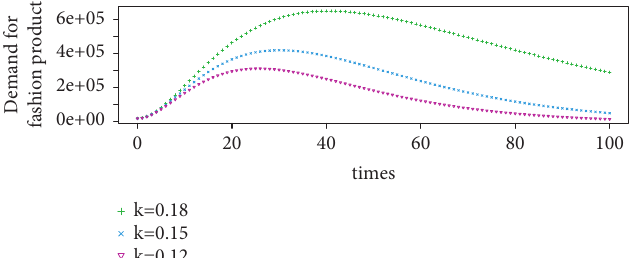
Figure 13: Simulation of the demand for fashion products at different effective rates of FPPEs application due to strict adherence to safety and precautionary measures. The effective rate of application ( k ) increases from 0.12 to 0.18, and the demand for fashion products shifts outward, signifying an increase in